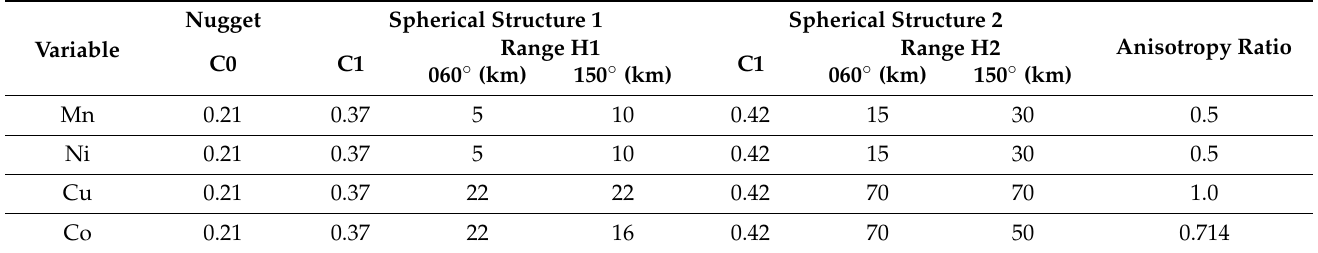
Table 5. Model grade variogram